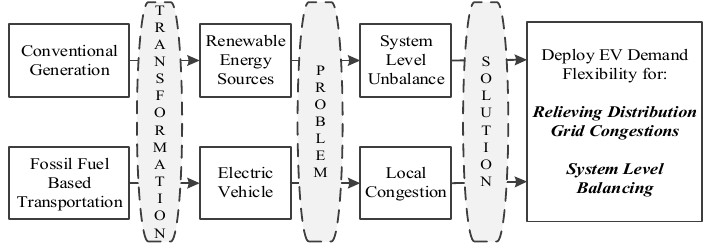
Figure 1. Future power system problem. EV: electric vehicle.